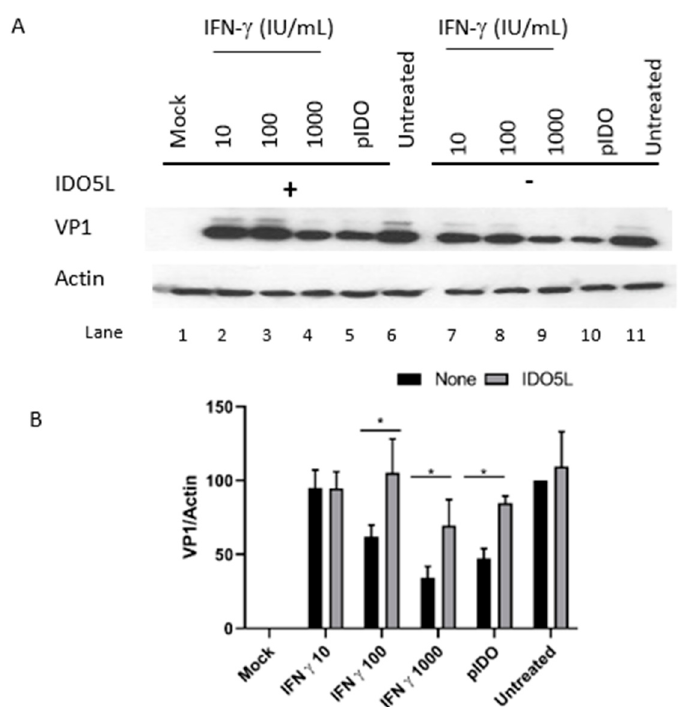
Figure 5. The effect of IDO on BKPyV infection. Caki cells were transfected with a plasmid carrying the human IDO1 gene (lanes 5 and 10) or treated with various concentrations of IFN gamma (lanes 2, 3 and 4, and lanes 7, 8 and 9). IDO5L was added to 6 samples (lanes 1 to 6). The cells were then infected 24 h post-transfection, and total proteins were harvested 3 days post-infection. ( A ) VP1 and actin were detected by Western blotting. ( B ) Densitometric analysis of VP1 (normalized against actin). The results in B corresponds to the mean ± SD of three independent protein samples per condition. “Mock” corresponds to non-infected cells and “Untreated” corresponds to cells infected in the absence of IFN. * p < 0.05.